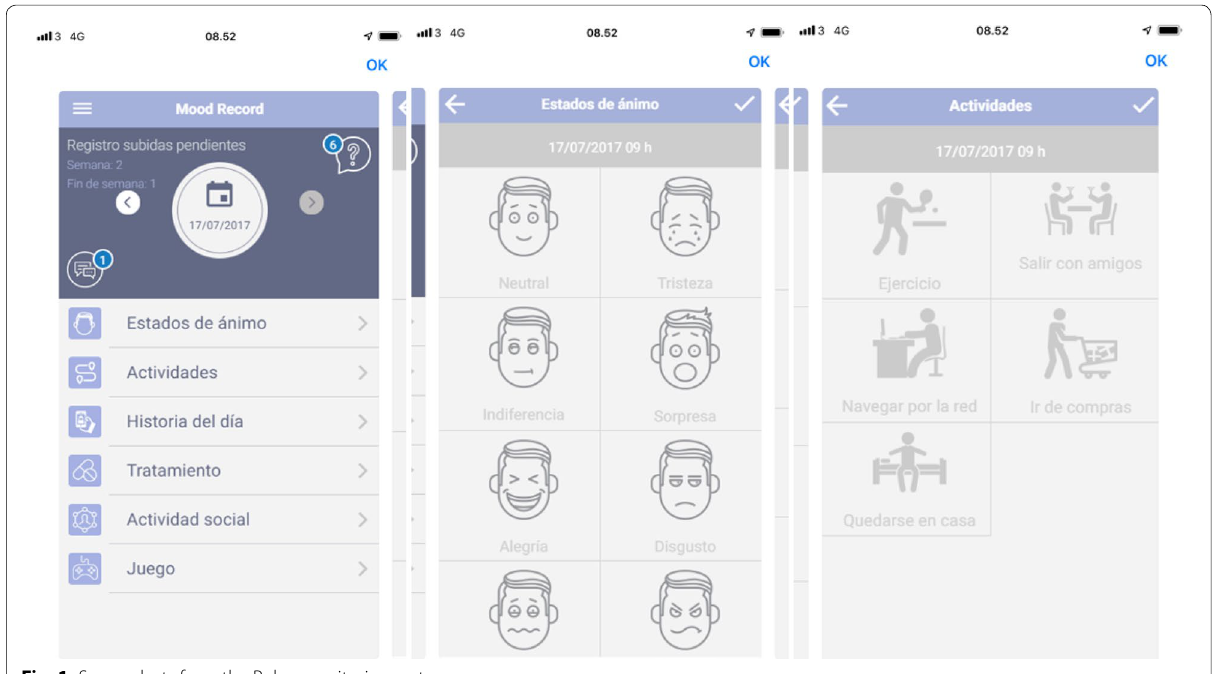
Fig. 1 Screenshots from the Pulso monitoring system